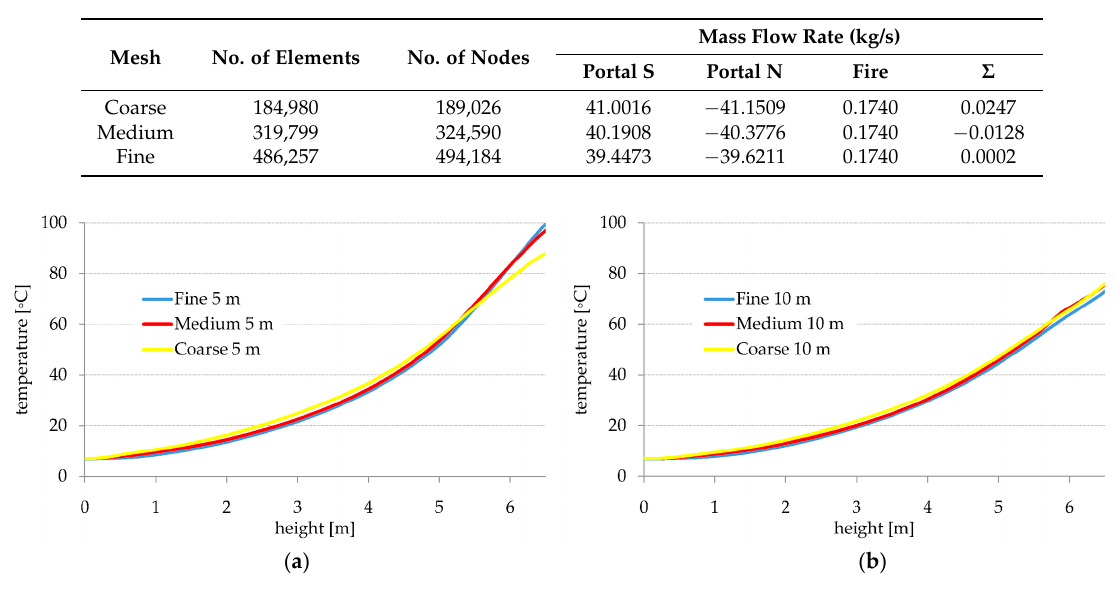
Figure 9. Temperature distribution at the tunnel axis on windward at: ( a ) 5 m and ( b ) 10 m from the last tray for three mesh densities.